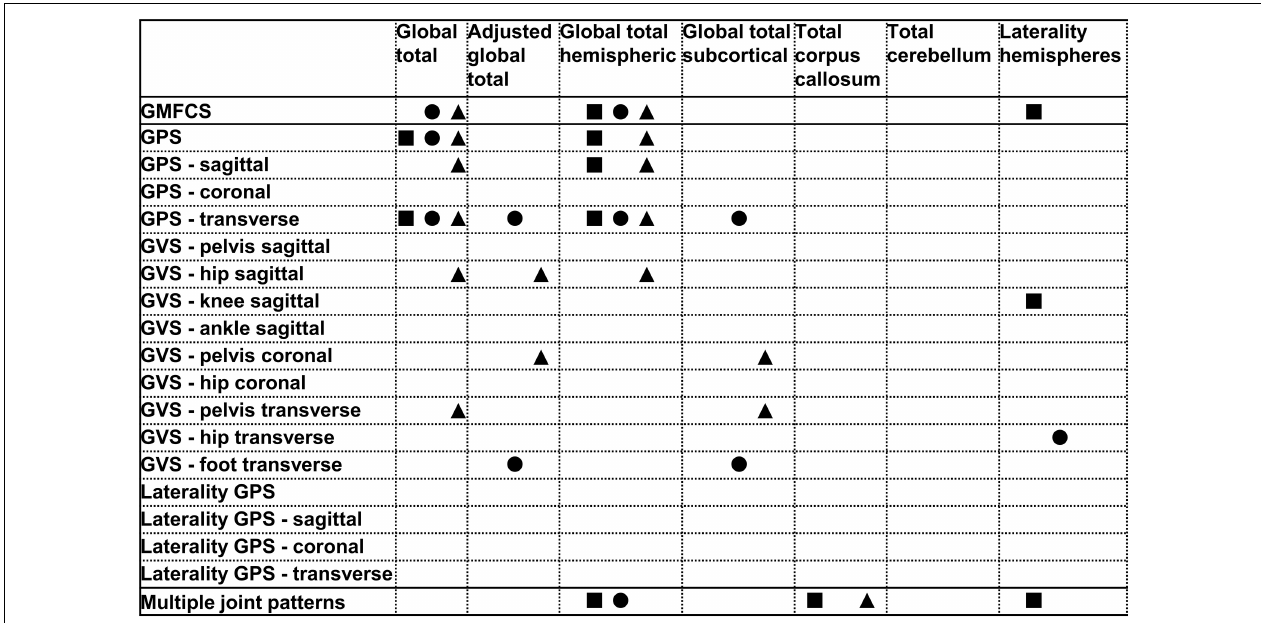
FIGURE 1 | Summary of all statistically significant relationships identified between the brain lesion extent scores and the functional and gait scores (i.e., GMFCS, GPSs, GVSs, and MJ patterns). The total group is depicted with a square, the bCP with a circle and the uCP with a triangle (from left to right: total, bCP, uCP). GMFCS, gross motor function classification system; GPS, gait profile score; GVS, gait variable score; MJ, multiple joint; bCP, bilateral cerebral palsy; uCP, unilateral cerebral palsy.